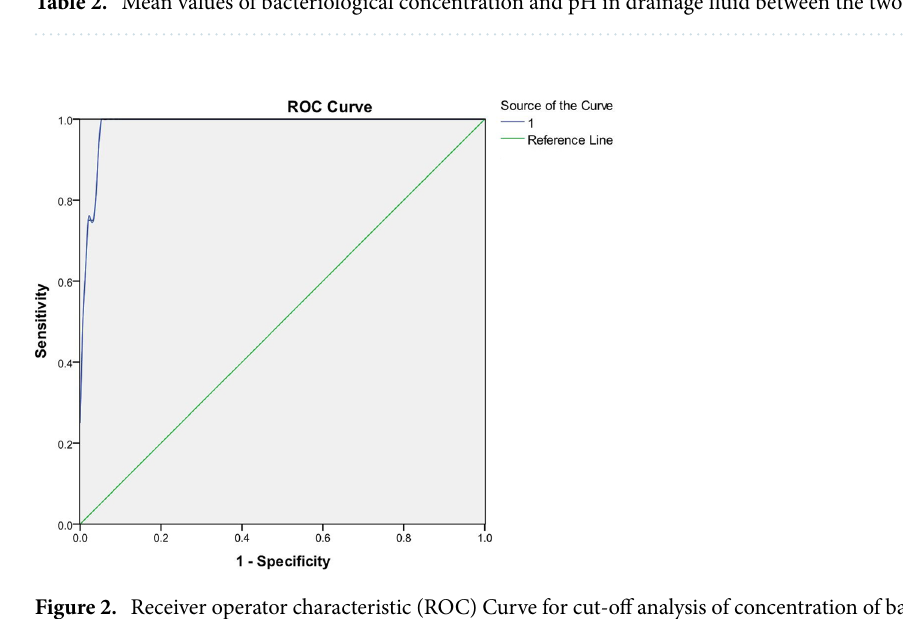
Table 2. Mean values of bacteriological concentration and pH in drainage fluid between the two groups.